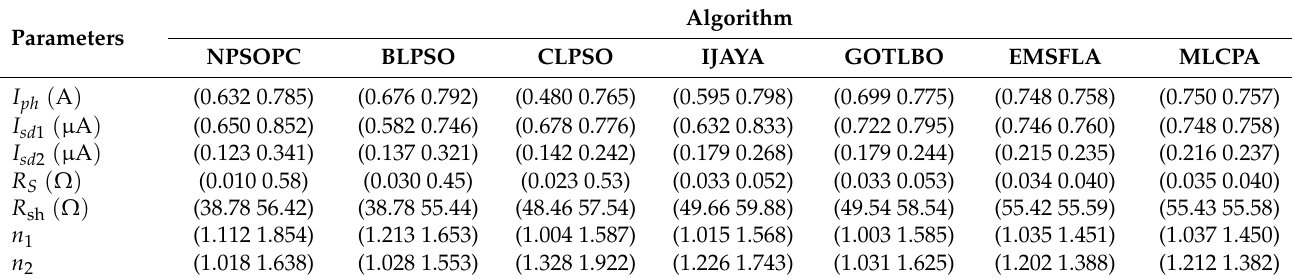
Table 10. Confidence intervals on